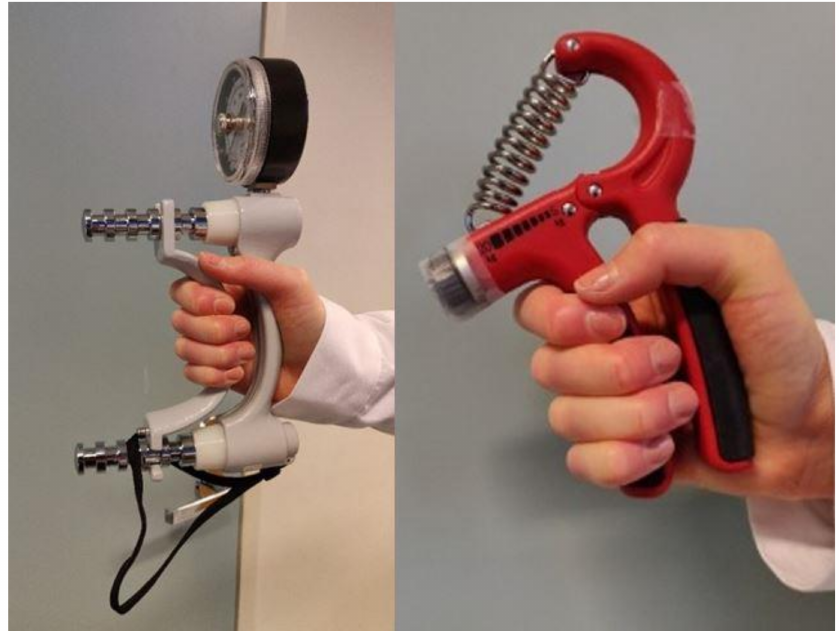
Figure 1. Hand grip strength measurement device ( left ) and hand grip endurance task device ( right